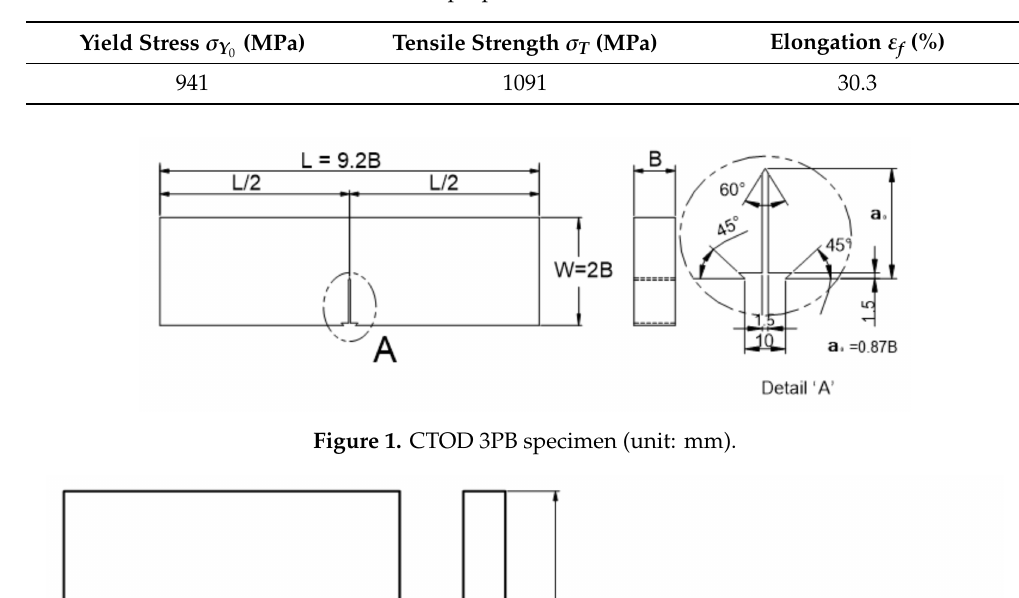
Table 2. Mechanical properties of 9% Ni steel at − 196 ◦ C.